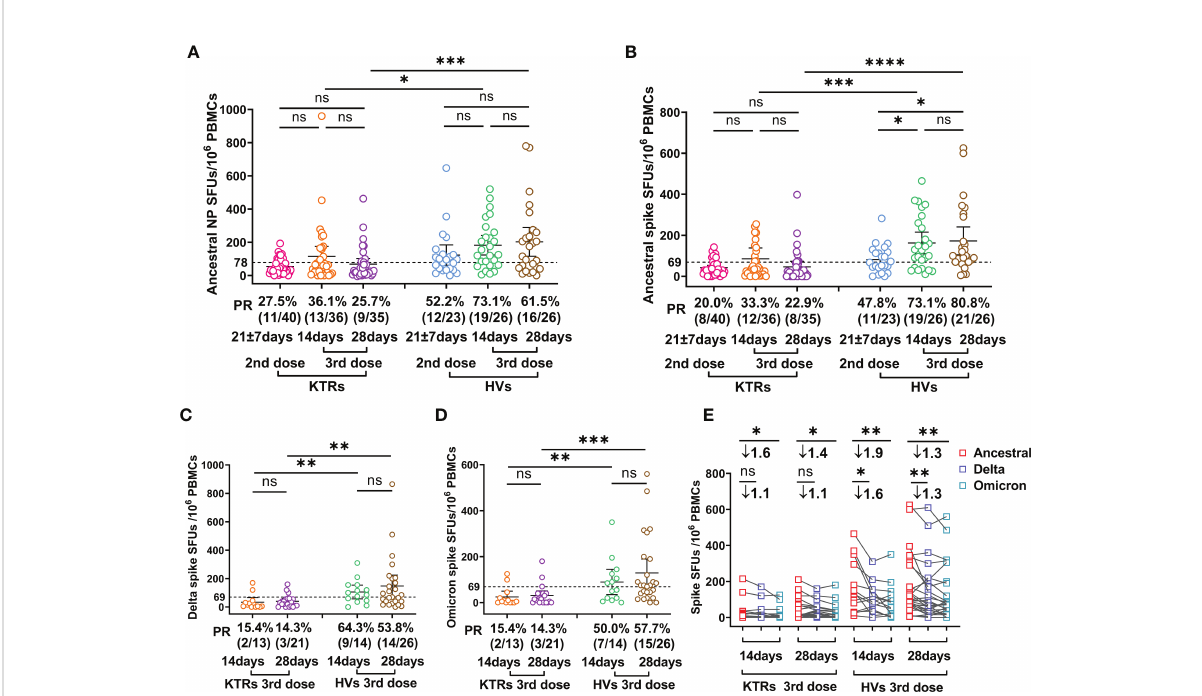
FIGURE 2 Comparative analysis of SARS-CoV-2 speci fi c T cell response between kidney transplant recipients (KTRs) and healthy volunteers (HVs) after the second booster and third homologous booster. (A-D) Ancestral nucleocapsid protein (NP) (A) , Ancestral (B) , Delta (C) , and Omicron (D) spike- speci fi c T cell frequency in KTRs and HVs 14-28 days after second vaccination with inactivated vaccine and 14 and 28 days post third homologous booster. (E) Paired analysis of Ancestral, Delta and Omicron spike-speci fi c T cell frequency in KTRs and HVs 21 ± 7 days after second vaccination with inactivated vaccine and 14 and 28 days post third homologous booster. Bar: median with interquartile range; dotted line: positive threshold; PBMC: peripheral blood mononuclear cell; SFUs: spot forming units; PR: positive rate. Statistical differences were determined by Mann-Whitney U test. P -values were indicated by ns, not signi fi cant (P > 0.05), * (p < 0.05), ** (p < 0.01), *** (p < 0.001), and **** (p <